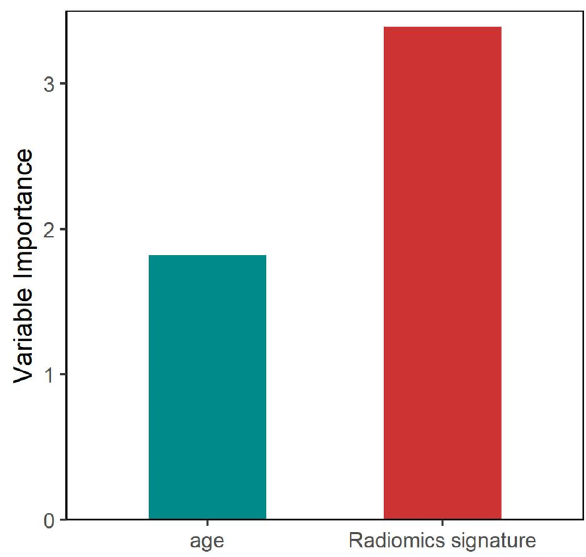
Figure 5. Variable importance of each variable in the radiomics nomogram.